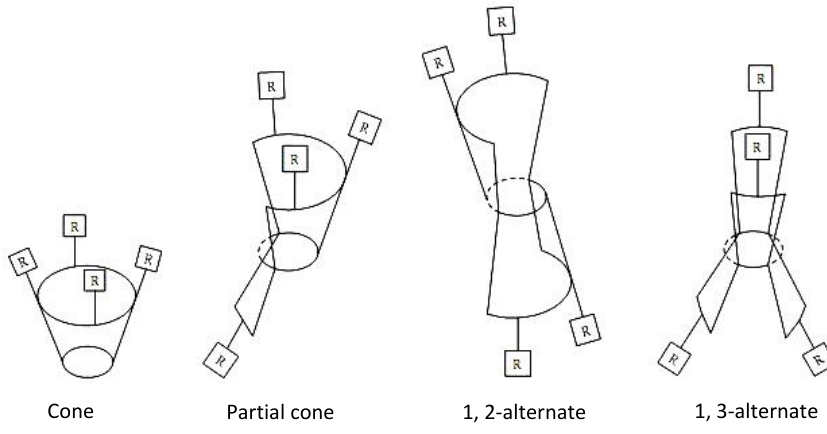
Figure 2. Conformers of cone shapes of